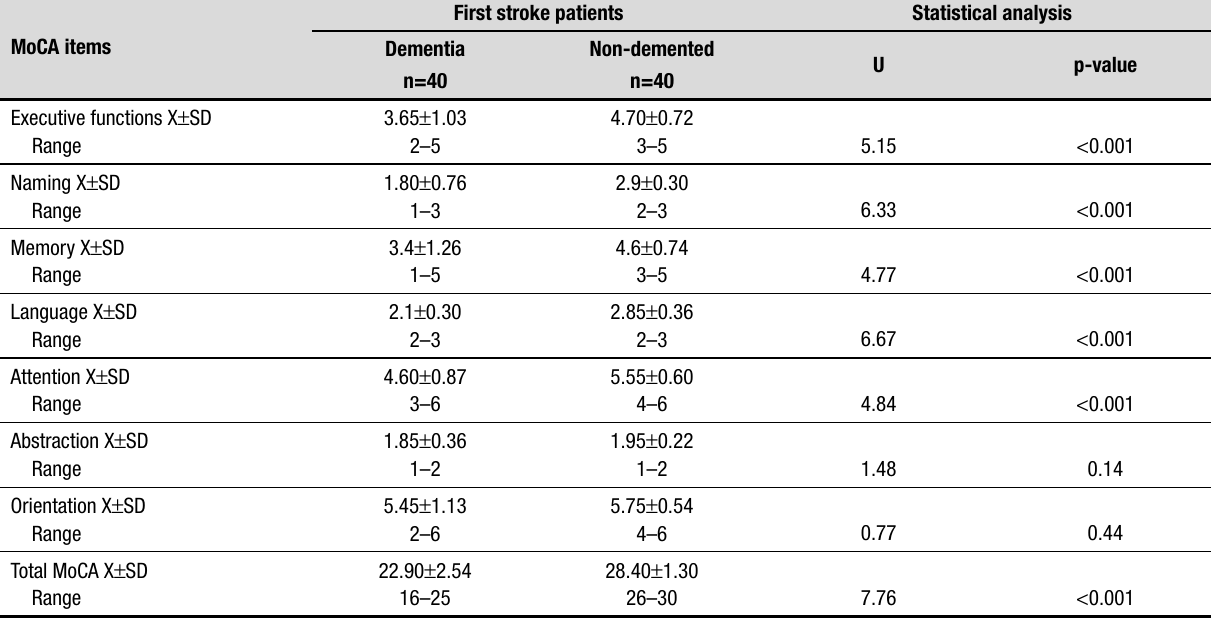
Figure 1. National Institute Health Stroke Scale among patients and controls.